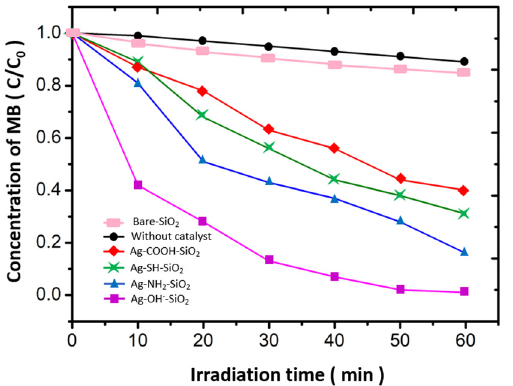
Figure 8. Concentration of methylene blue (MB) (C/C 0 ) irradiation time plots for MB photodegrada- tion in the presence of four kinds of photocatalysts. Without catalyst and bare-SiO 2 for comparison. (C 0 is the initial concentration of MB and C is the concentration at a certain minute of MB) (the reaction temperature is at room temperature and the pH value is 9).